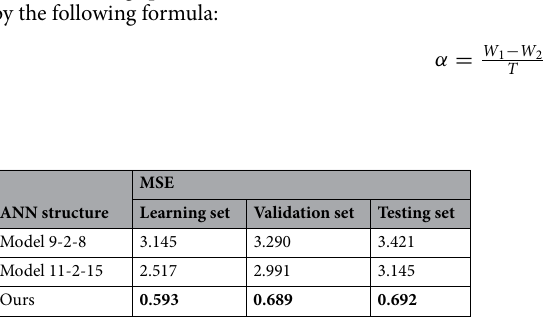
Table 1. Performance of different ANN structure. Significant values are in